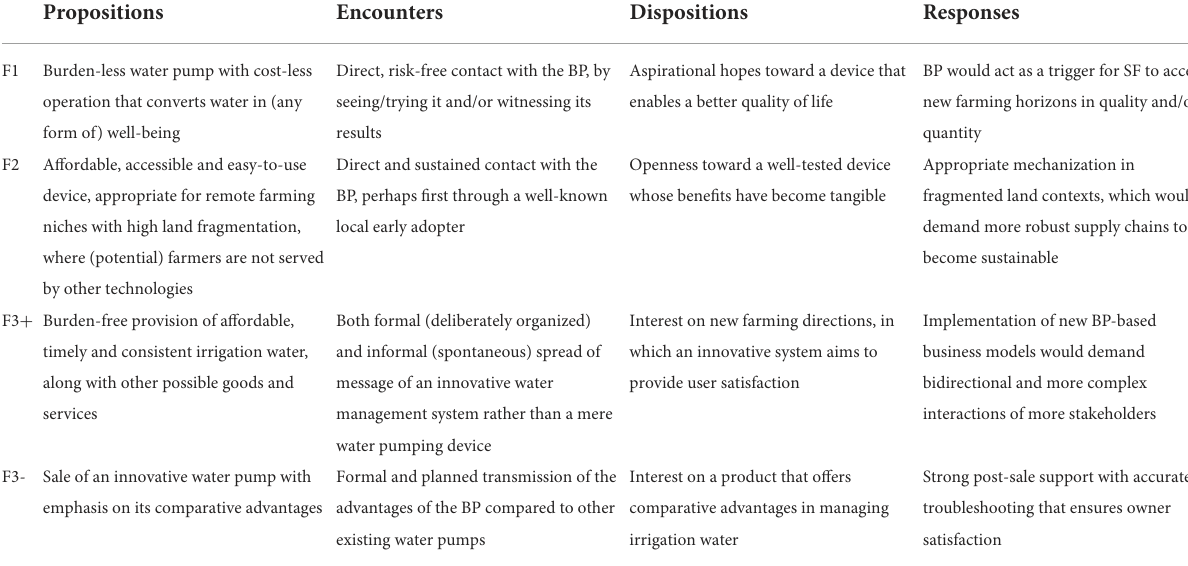
TABLE 8 Suggested pathways to provide the BP with respect to each factor, based on the conceptual framework of Glover et al.